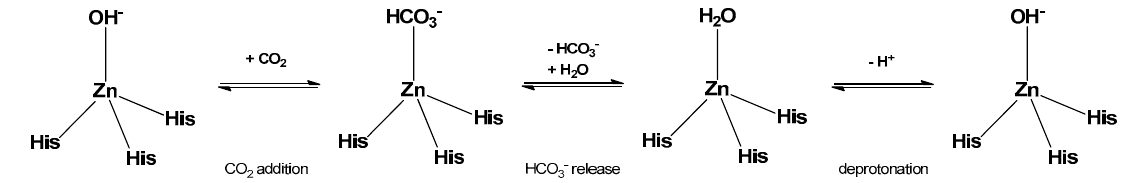
Figure 4. Proposed mechanistic processes for the catalytic cycle of CA.